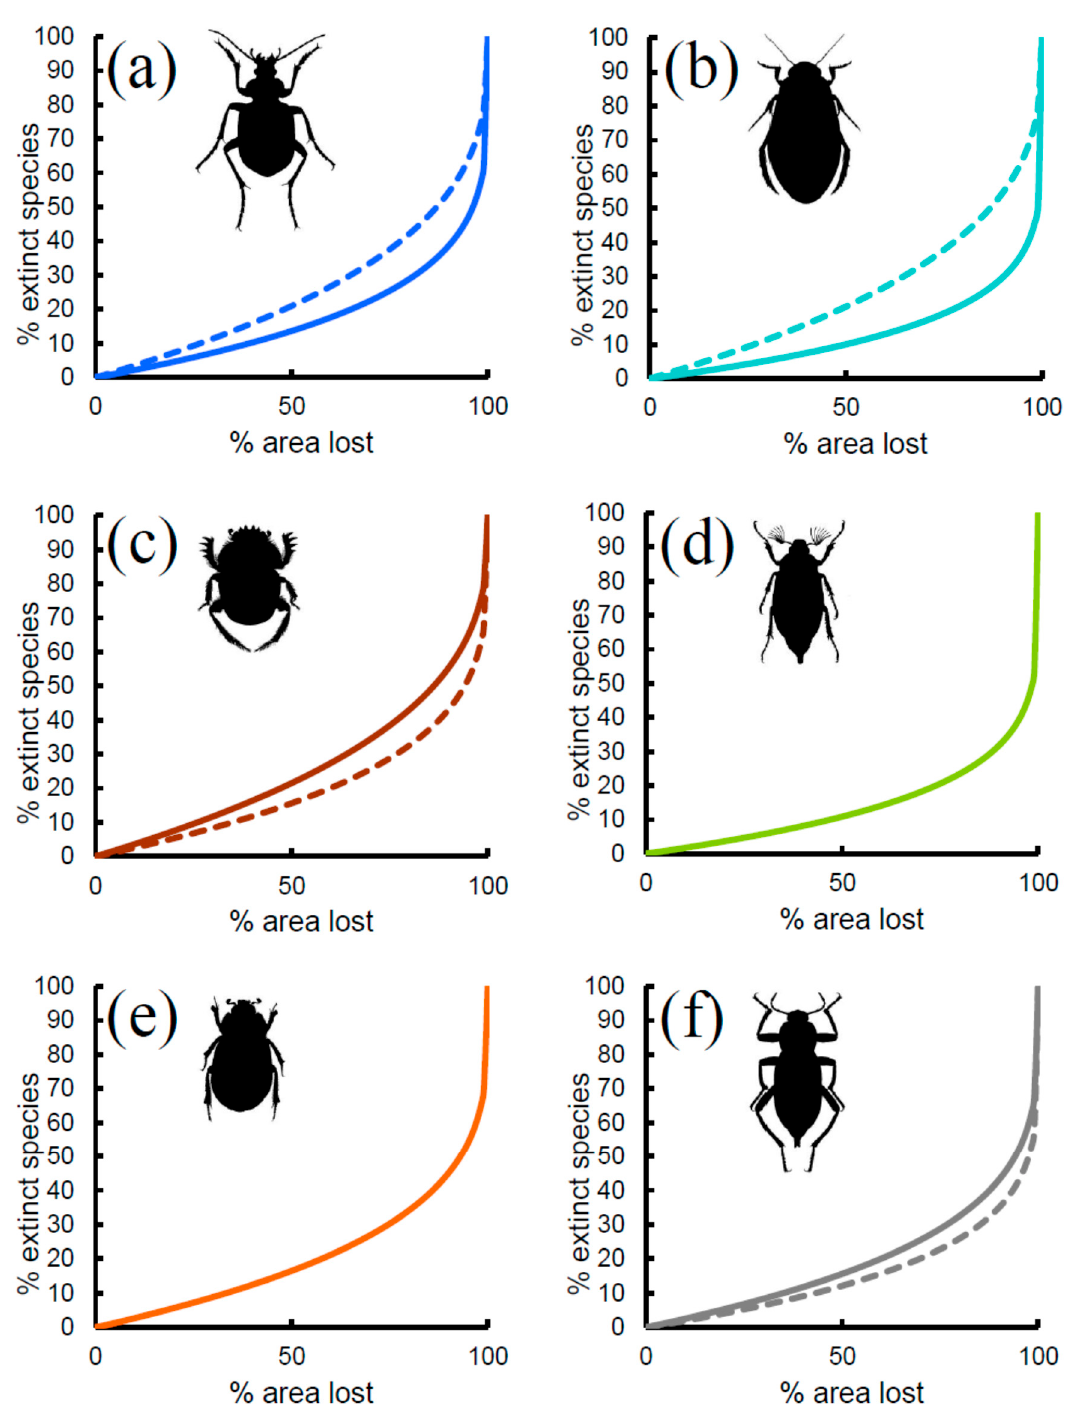
Figure 3. Extinction rates (% of extinct species) expected on the basis of area loss (% of area lost) for various beetle groups in Italian reserves: ( a ) Carabidae, ( b ) Hydradephaga, ( c ) coprophagous Scarabaeoidea, ( d ) phytophagous Scarabaeoidea, ( e ) total Scarabaeoidea, ( f ) Tenebrionidae. Solid lines: expected rates from the species–area relationship. Dashed lines: expected rates from multiple regression models.